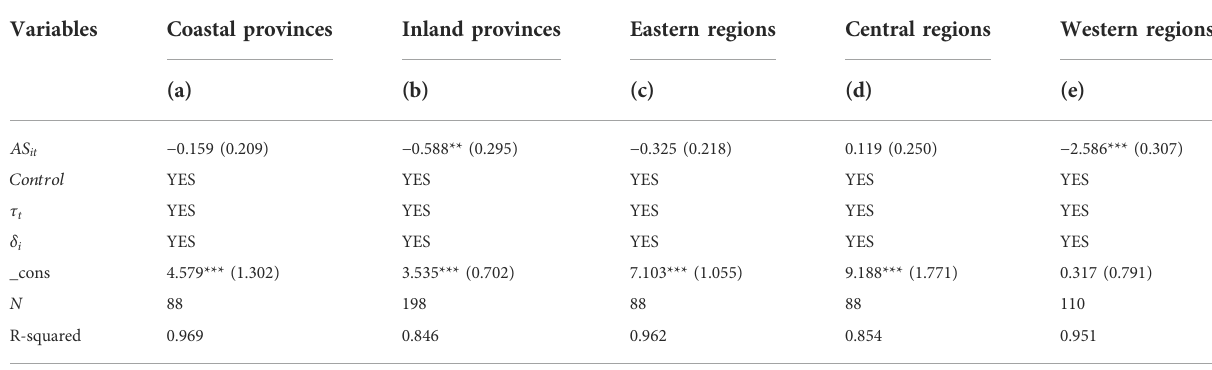
TABLE 9 Heterogeneity analysis.